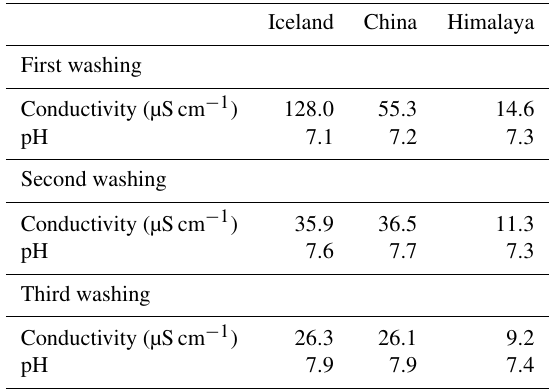
Table 3. Conductivity and pH of the supernatant water of the three washing procedures of the untreated dusts. The conductivity of pure Milli-Q water was 2µScm − 1